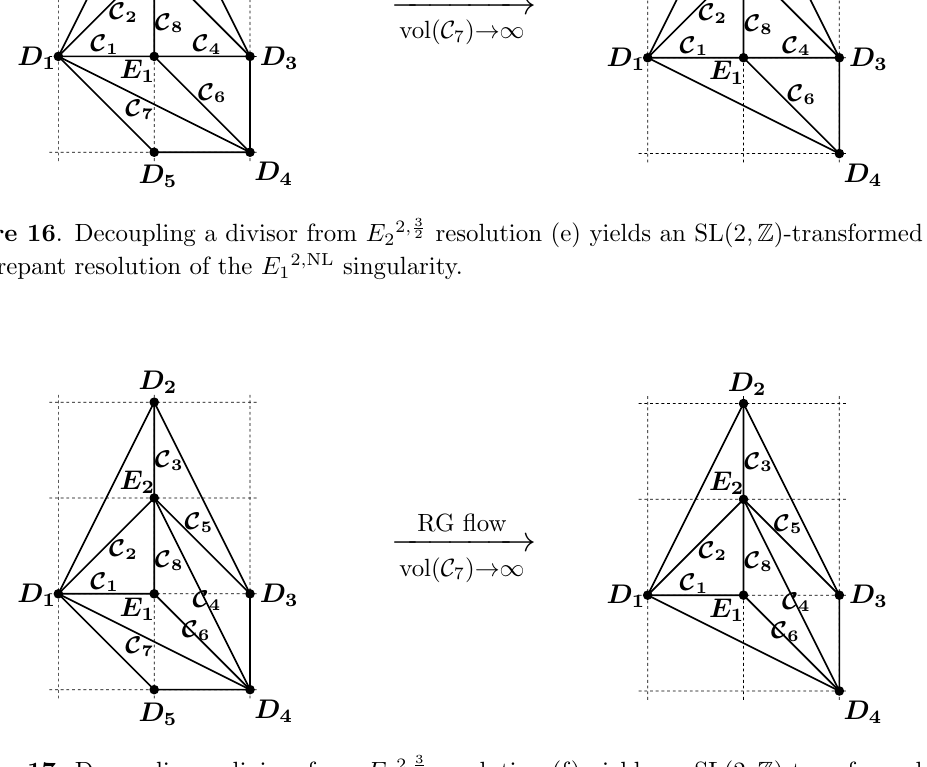
Figure 17 . Decoupling a divisor from E 22 ; 3 2 resolution (f) yields an SL(2 ; Z )-transformed version of a crepant resolution of the E 12 ; NL singularity.